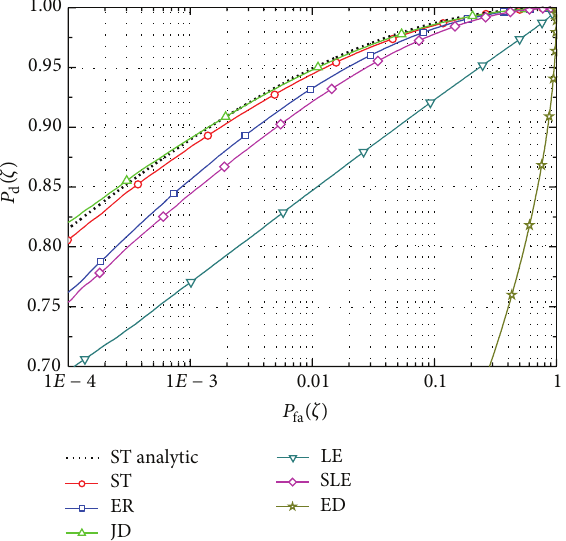
Figure 15: ROCs over a Rayleigh fading channel, for 𝐾 = 4, 𝑁 = 200, 𝑃 = 3, and SNR 1 = SNR 2 = SNR 3 = − 3 . 3239 dB, with 𝜇 = 0 . 5 dB for the LE and the ED.